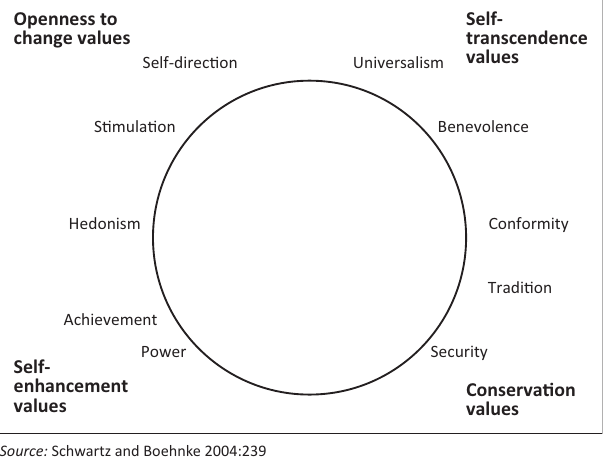
FIGURE 1: The Schwartz values theoretical circumplex